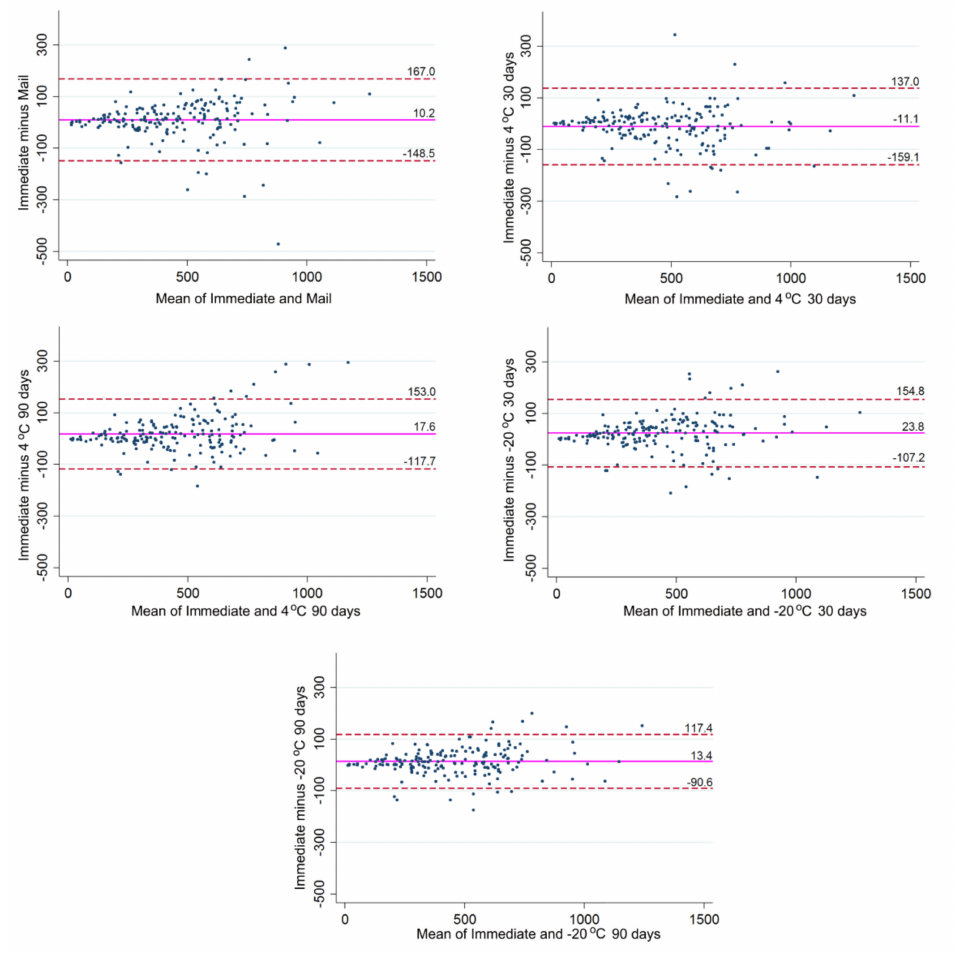
Figure 1. Bland-Altman plots of the five di ff erent storage conditions plotted against immediate analysis after − 80 ◦ C thawing. The magenta reference line illustrates the mean disagreement; the red dashed lines state the upper and lower limits of agreement. All values are expressed in nanograms of cotinine per milliliter of sample (ng /